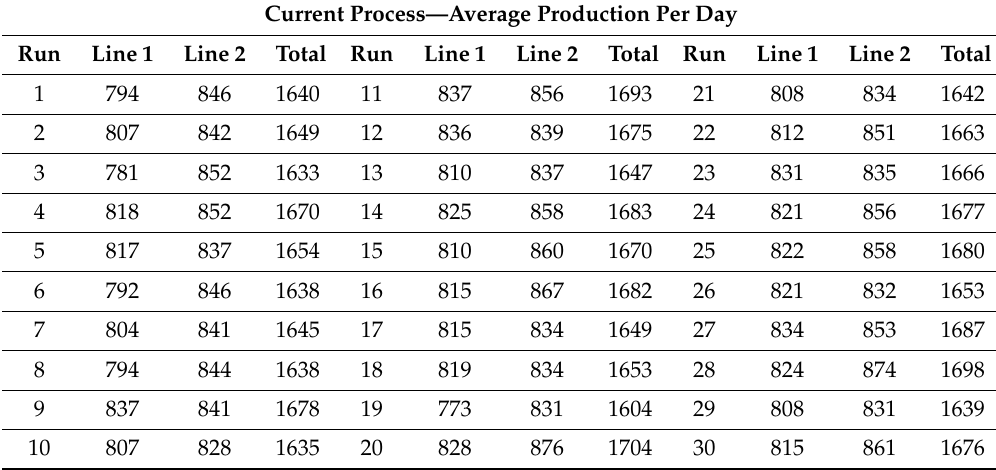
Table 9. Average production / day of the current process.